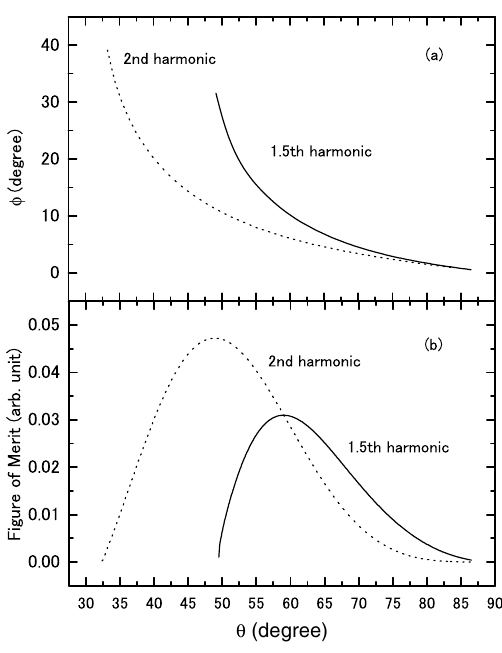
FIG. 5. (a) P and (b) F at the 2nd and 1.5th harmonics C (cid:1) 1 . (b) Calculated F using FIG. 4. (a) and (cid:31) to obtain P calculated using the optimized parameters shown in Fig. 4(a). C the parameters shown in (a). The solid lines show the 1.5th These calculations take into account the electron beam harmonic and the dotted lines show the 2nd harmonic. emittance.